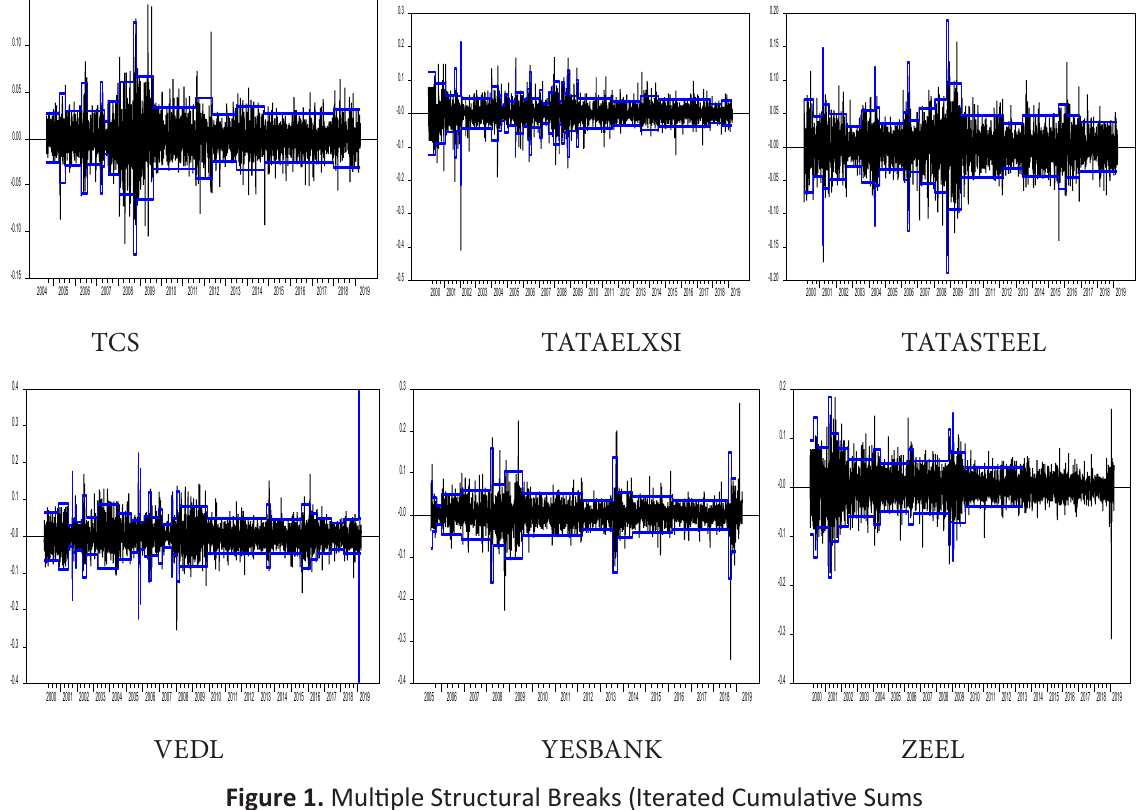
Figure 1. Multiple Structural Breaks (Iterated Cumulative Sums of Squares (ICSS) algorithm of Inclan and Tiao